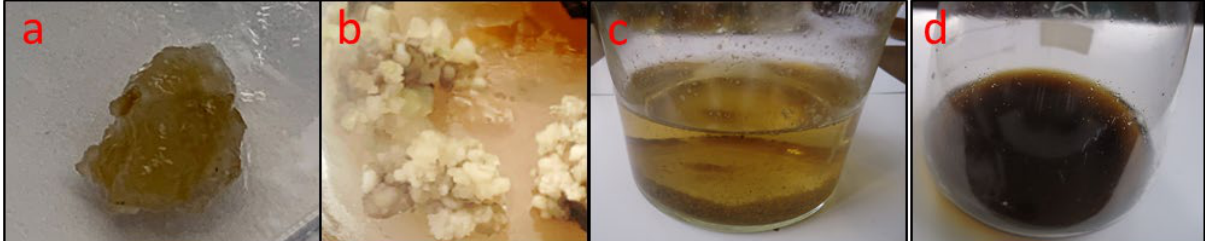
Figure 1. O. basilicum callus and cell suspension in MS and LS medium consisting of kinetin (0.5 mg/L), NAA (0.5 mg/L), 3% ( w / v ) sucrose, 2,4-D (0.1 mg/L), and IBA (1 mg/L); ( a ) initiation of callus after seven days, ( b ) initiation of callus after 25 days, ( c ) cell suspension after 15 days, and ( d ) cell suspension after 40 days via somatic embryogenesis. IBA: indole butyric acid; NAA: 1-naphthaleneacetic acid; and 2,4-D: 2,4-dichlorophenoxyacetic acid.